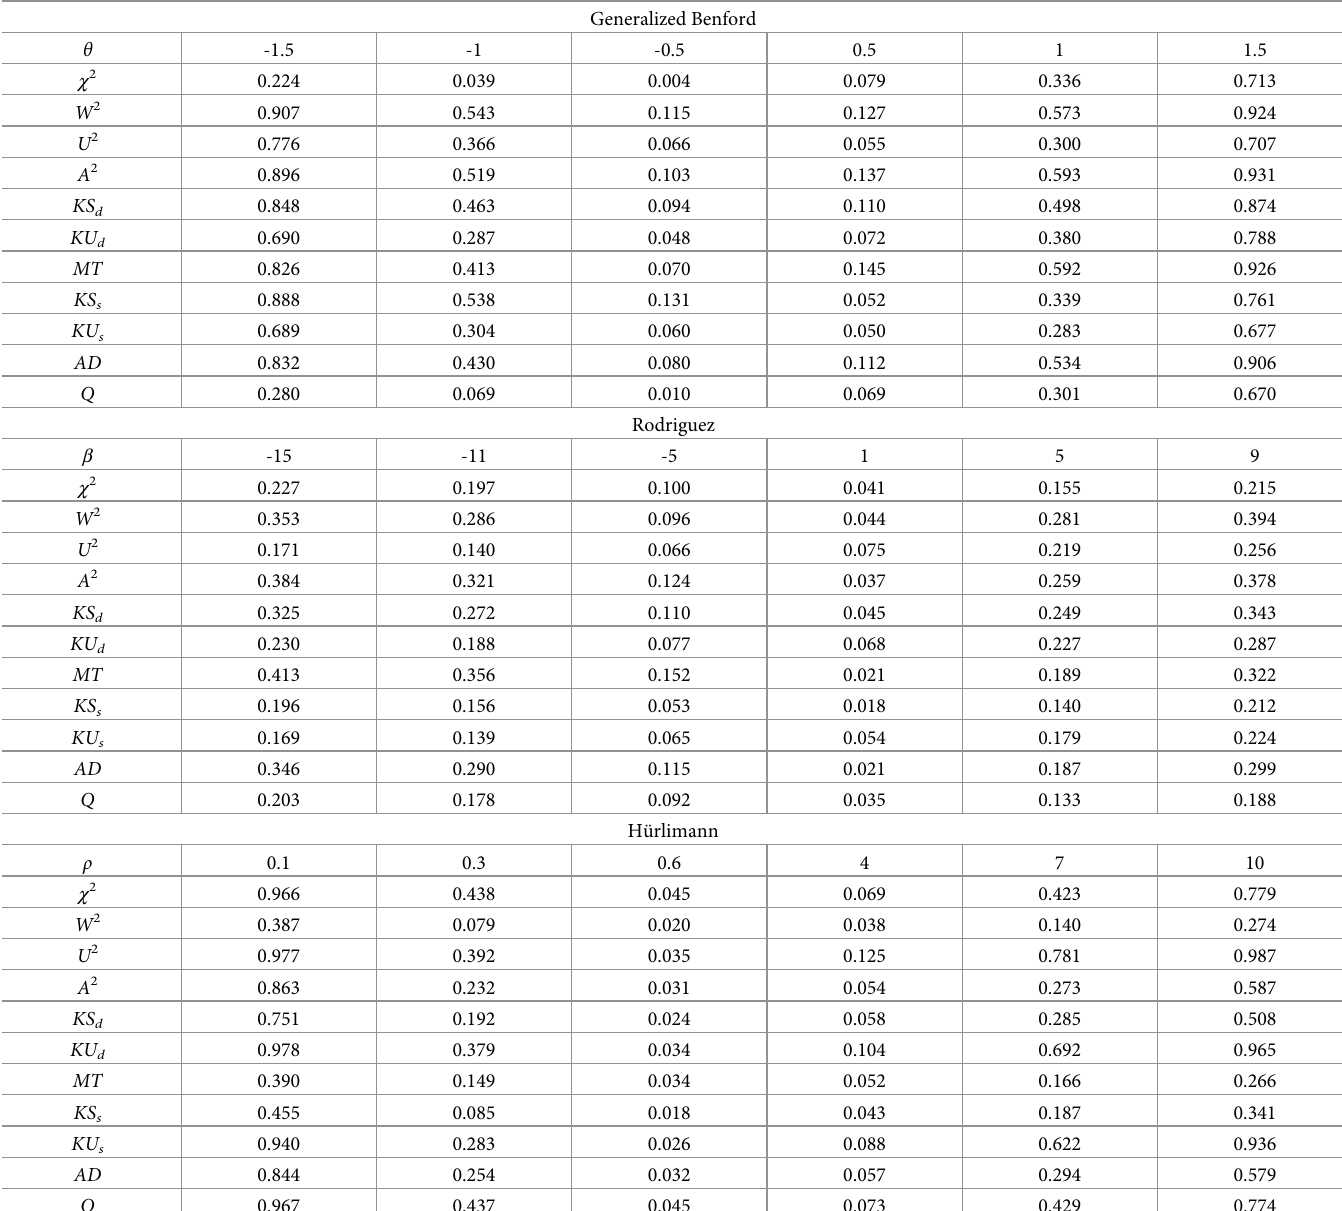
Table 3. Rejection rates when the FSD is distribuited according to Eqs (13), (14) and (15).